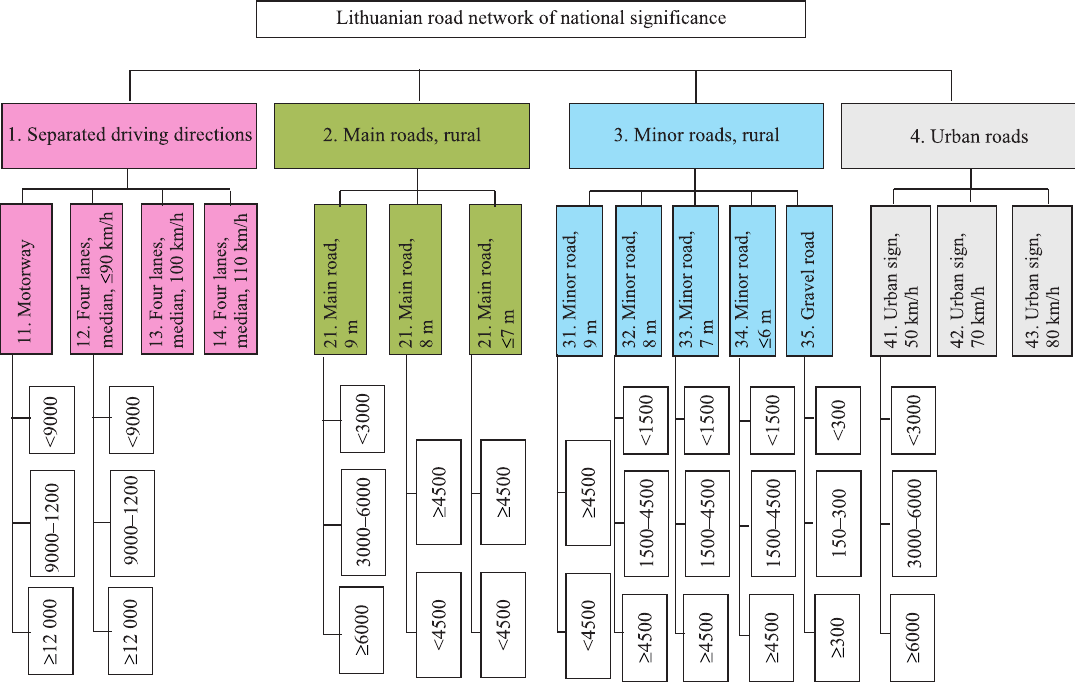
Fig. 1. The scheme on the division of road sections into groups and subgroups by AADT in